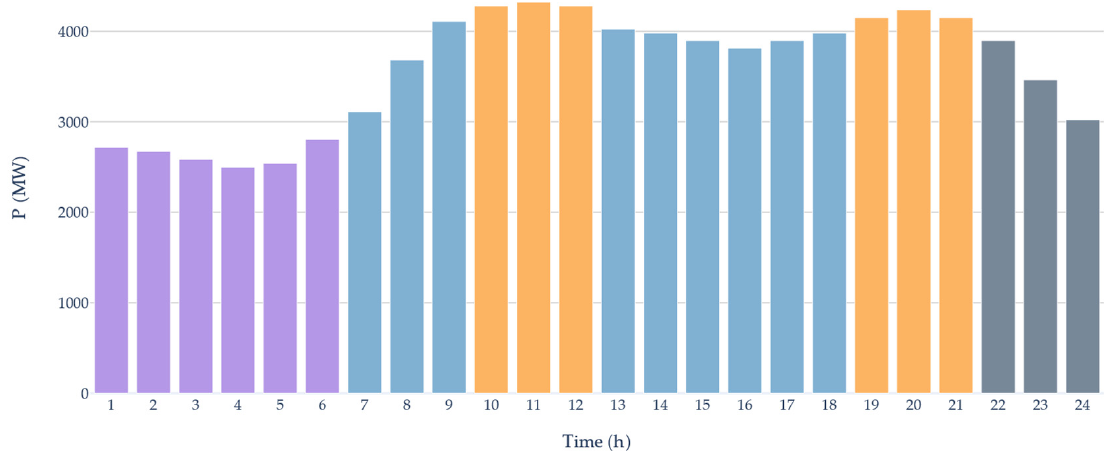
Figure 1. The 24 h load curve performed on the IEEE 118-bus test system.